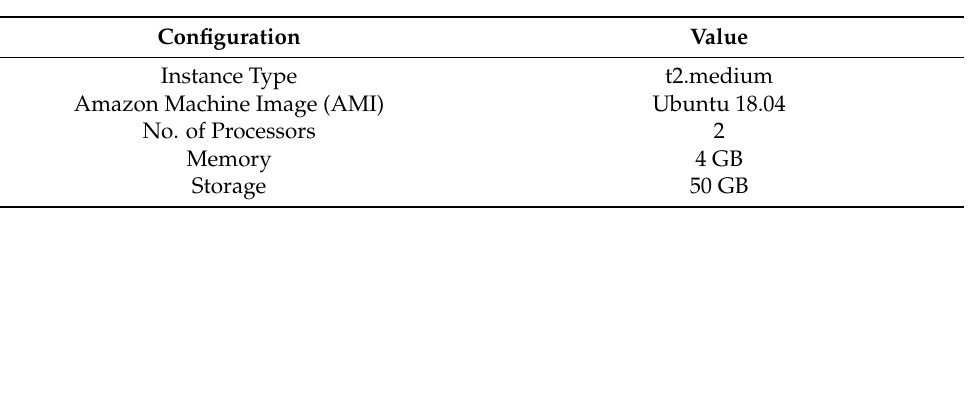
Figure 13. Combined results of the response times in a local machine.